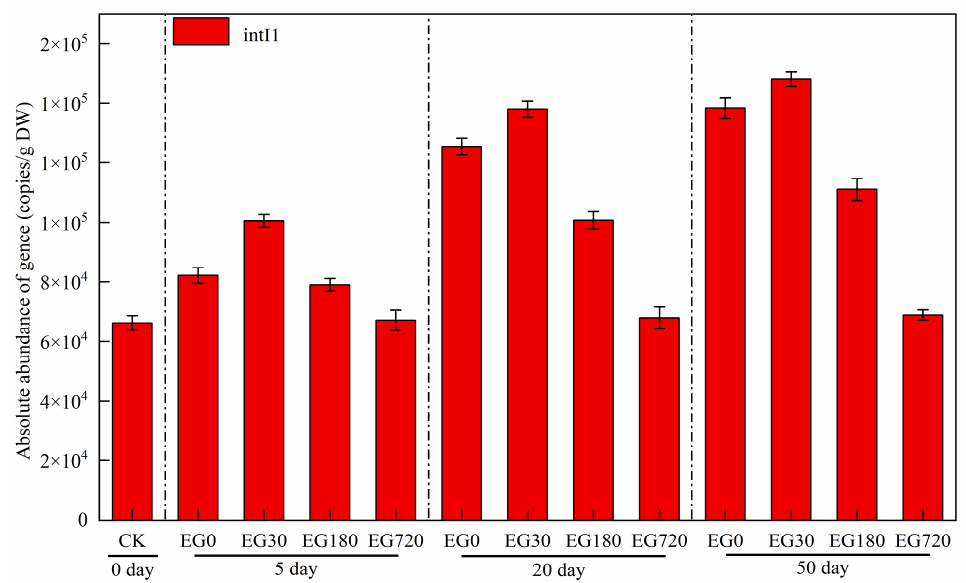
Figure 7. Changes in the absolute abundance of the intI1 gene in various samples.